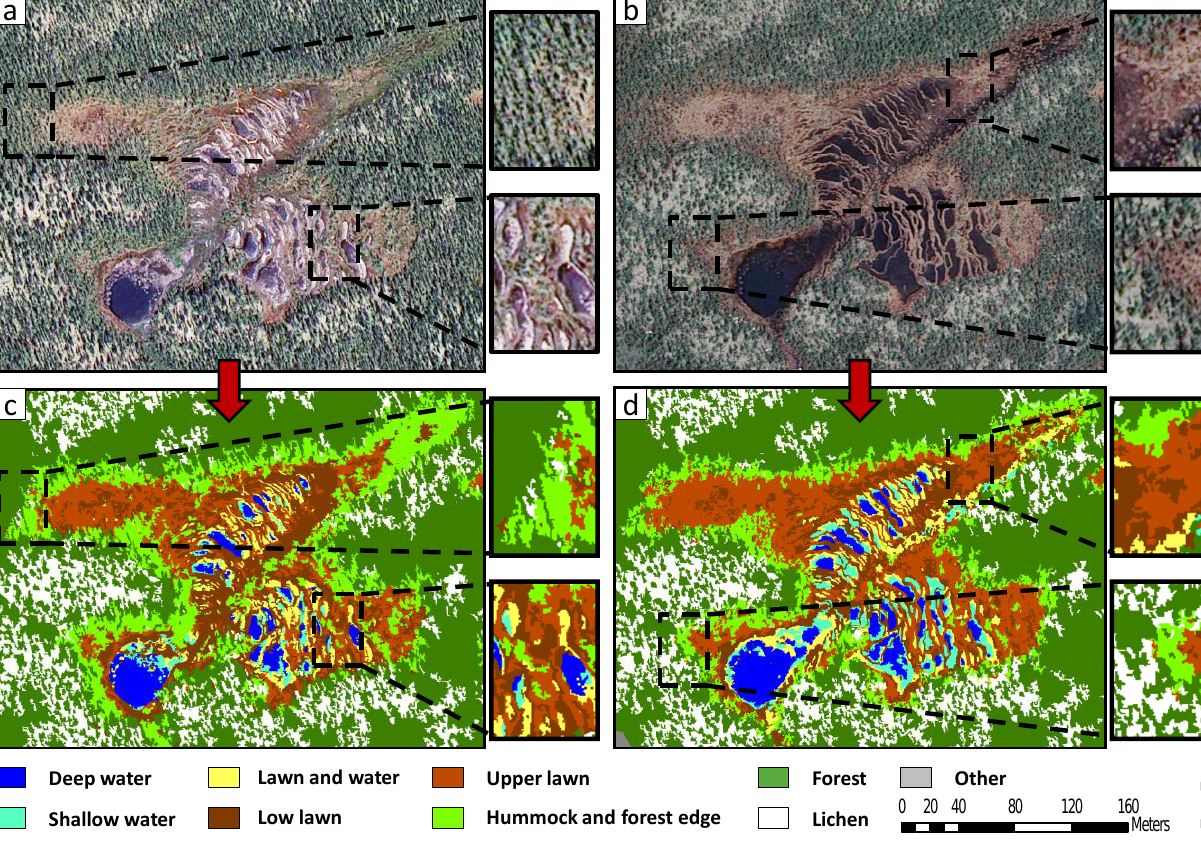
Table 3. Confusion matrix for 9 June 2010 image coarse-scale classification (Step 2), considering the original classes of the validation